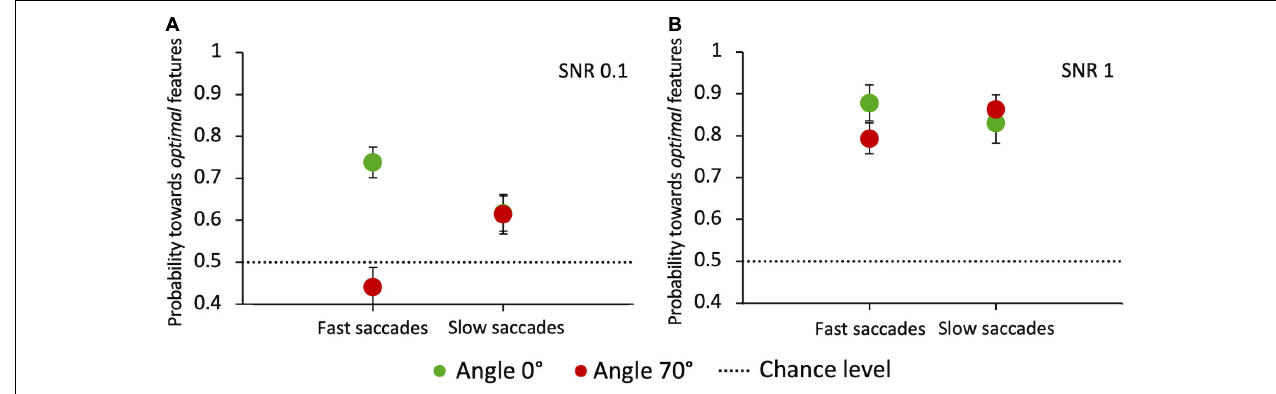
FIGURE 11 | Probability of saccades toward the target as a function of latency, at angles 0 ◦ and 70 ◦ . (A) Probability of saccades toward the target for SNR 0.1. (B) Probability of saccades toward the target for SNR 1. Data are pooled across observers (weighted means with errors). “Fast” and “slow” saccades are determined, subject by subject, based on whether they were below or above the individual median latency, respectively. Green circles: angle 0 ◦ ; red circles: angle 70 ◦ . The dashed line indicates the guessing level (0.5 probability).